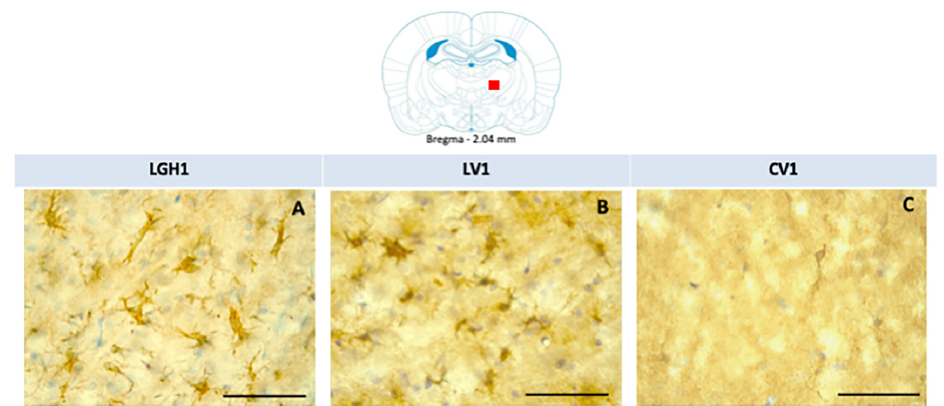
Figure 9. Actin immunoreactivity in the thalamic ventral nucleus (VA / VL complex) ipsilateral to the lesion in the three experimental groups of animals. Active microglia / macrophage-like cells, actin + , in a rat treated with GH ( A ) or vehicle ( B ). No differences were observed in the actin-immunoreactivity (ir) between animals treated with GH ( A ) or vehicle ( B ) immediately after injury. No actin-ir was found in control animals ( C ). Scale bar: 50 µm. Coronal sections at − 2.04 mm from Bregma. The red square indicates the place where the images were taken.